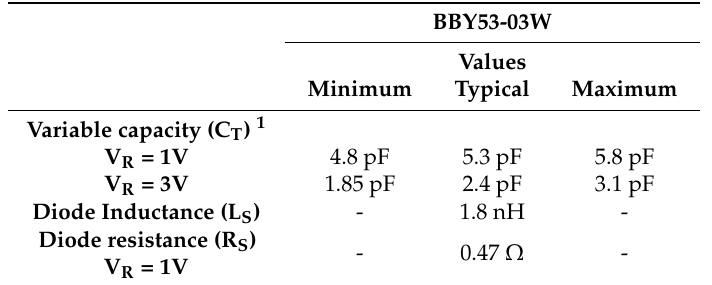
Figure 11. Quality factor as a function of substrate height. Table 8. Characteristics of varicap diodes.